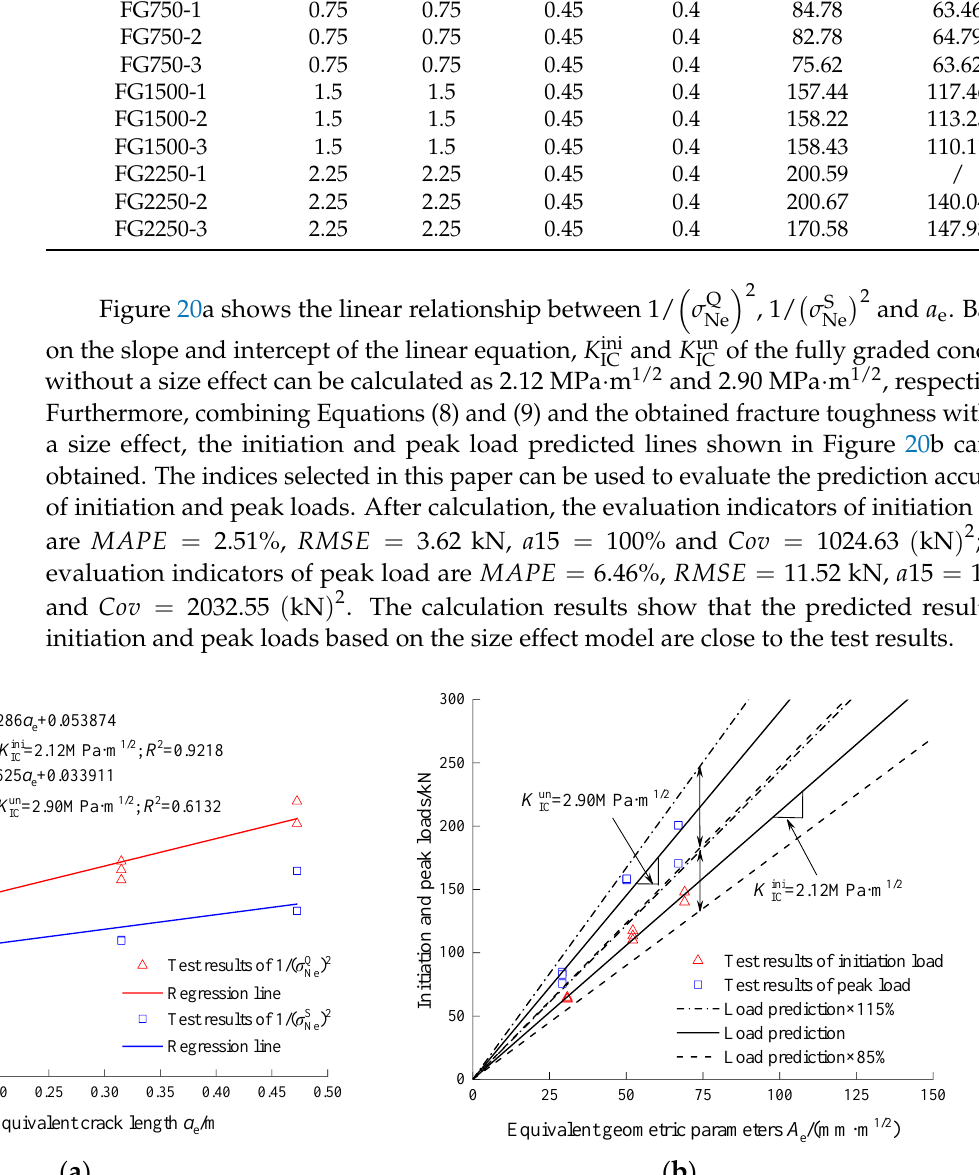
Figure 20. ( a ) Linear relationship of the size effect model; ( b ) predictions of initiation and peak loads. Figure 21a,b show comparisons between the predicted results and the test results of a , and Q K of fully graded concrete specimens with different sizes and an I C c w is 350 μm. It can be seen from Figure 21a that initial of 0.4 when the optimum 0 c a are close to the predicted results, and the prediction accuracy indices the test results of c are 2 . 61 % = M A PE and . From Figure 21b, N K and increase with increased specimen size and tend IC toward